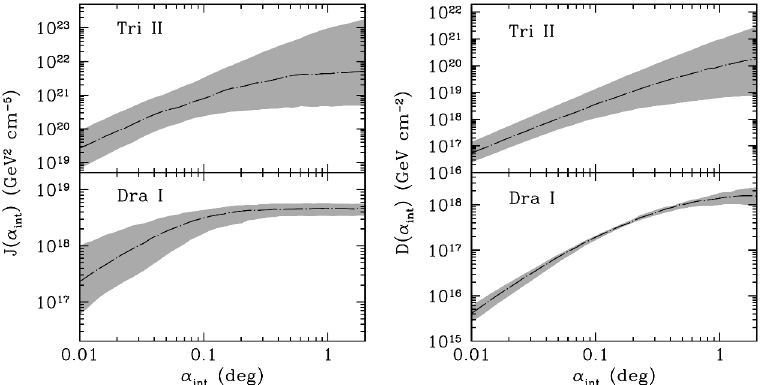
Figure 2: Left panels: DM-annihilation astrophysical factor profiles J ( α most massive halo (Tri II) and the halo with the most robust parameter determination (Dra I). Right panels: equivalent profiles D ( α int ) for DM